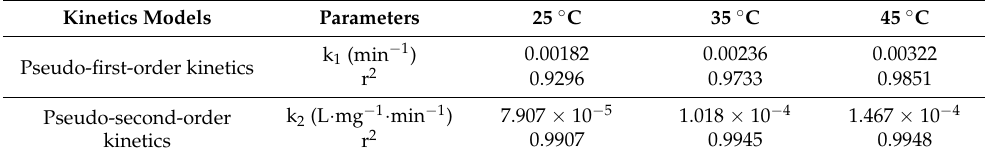
Table 2. The pseudo-first-order kinetics and pseudo-second-order kinetics fitting parameters. Kinetics